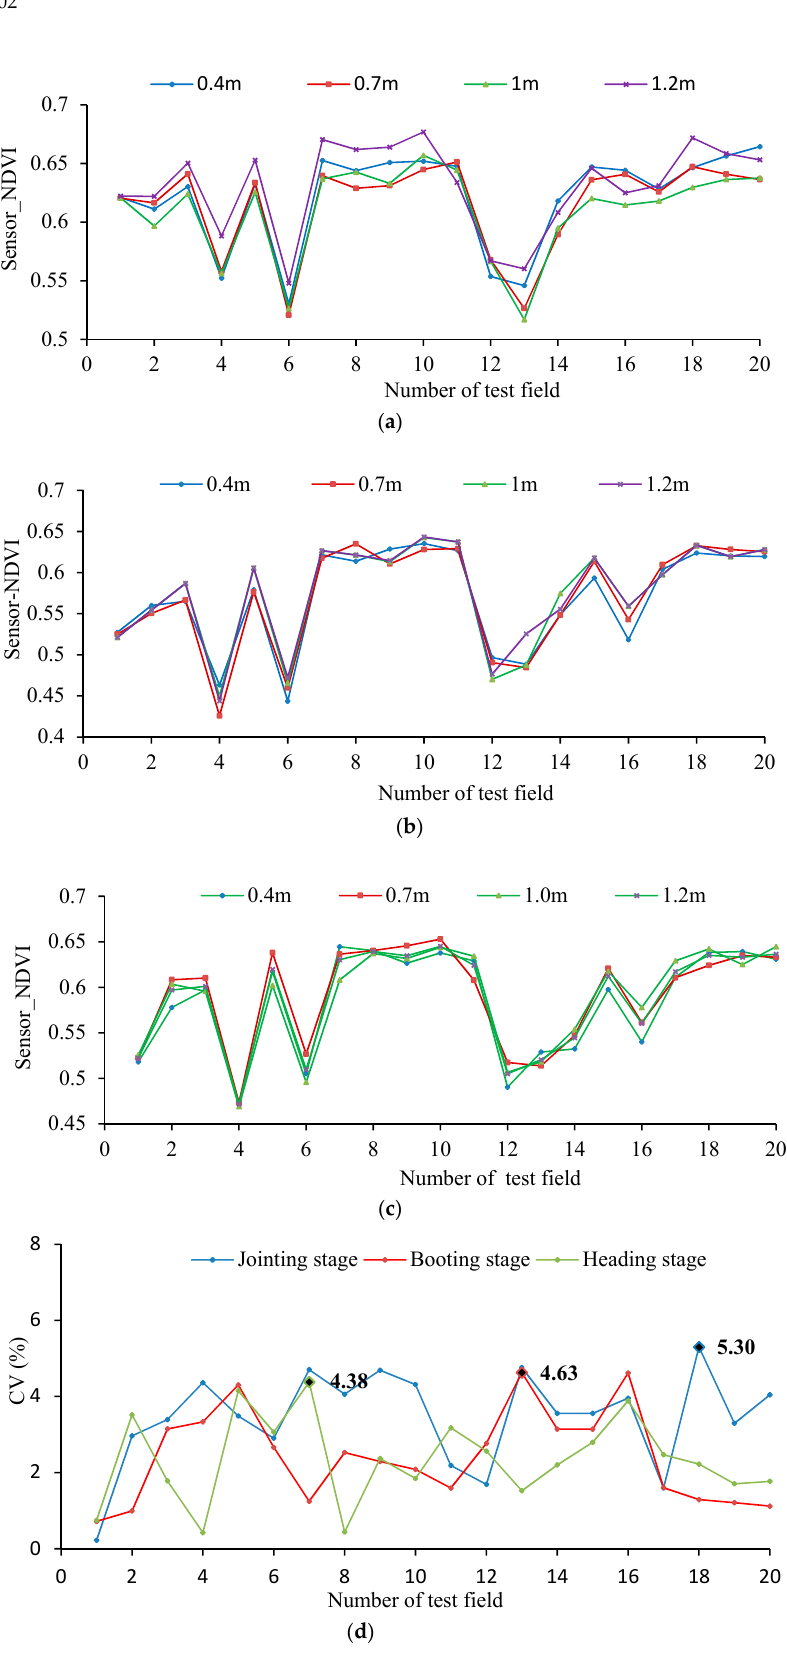
Figure 15. NDVI values measured using the sensor fixed onto the UAV for different elevations. ( a ) Jointing stage; ( b ) Booting stage; ( c ) Heading stage; ( d ) Deviation coefficients of the NDVI values measured.